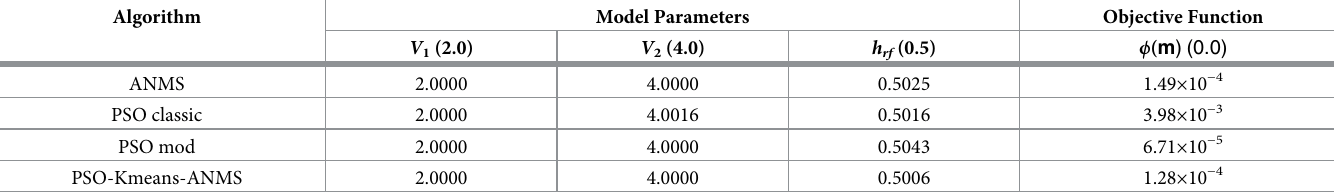
Table 8. Case 1 (100 × 20). Results of model parameters and objective function (misfit) for the best solution obtained in each optimization algorithm. Algorithm